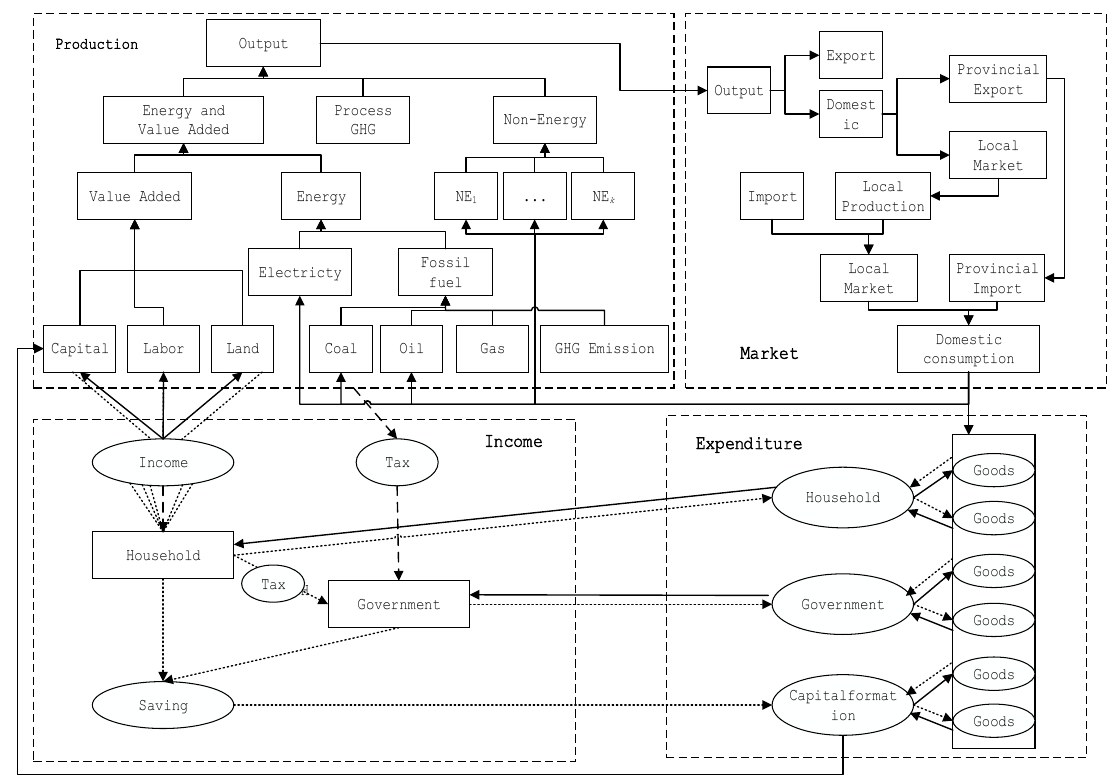
Figure 1. Model architecture. Table 1. Classification of production